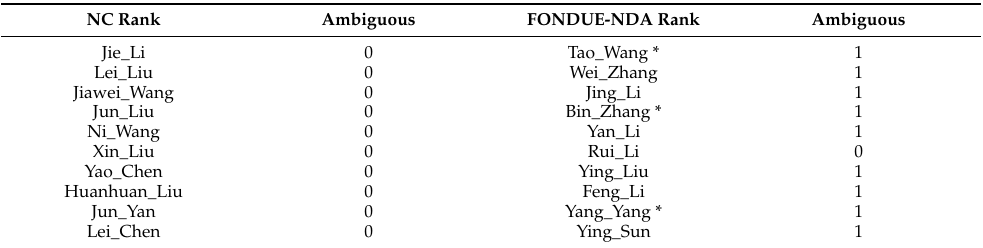
Table 5. The top 10 ranked nodes of FONDUE-NDA and NC, against the ground truth (1 if the node is ambiguous and 0 otherwise). FONDUE-NDA correctly classifies 9 out of the 10 nodes as ambiguous. Names with * are highly ambiguous, referring to more than 2 Orcid IDs. NC Rank Ambiguous FONDUE-NDA